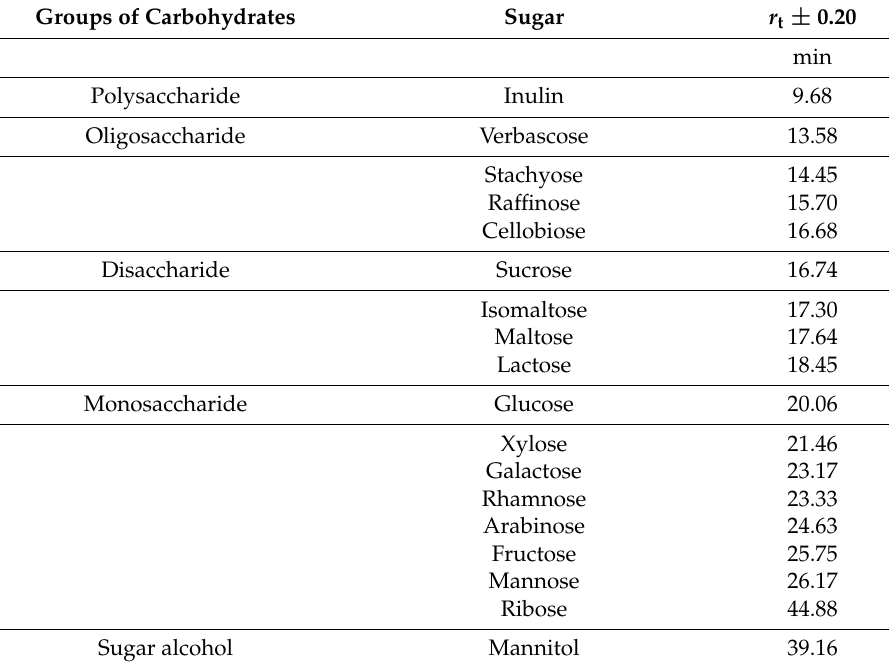
Table 3. Retention times of sugar specie, analysed by HPLC with a Pb 2+ column CHO 682 heated